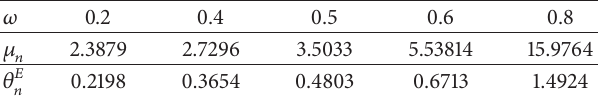
Table 3: Observables for the supermassive BH at the galactic